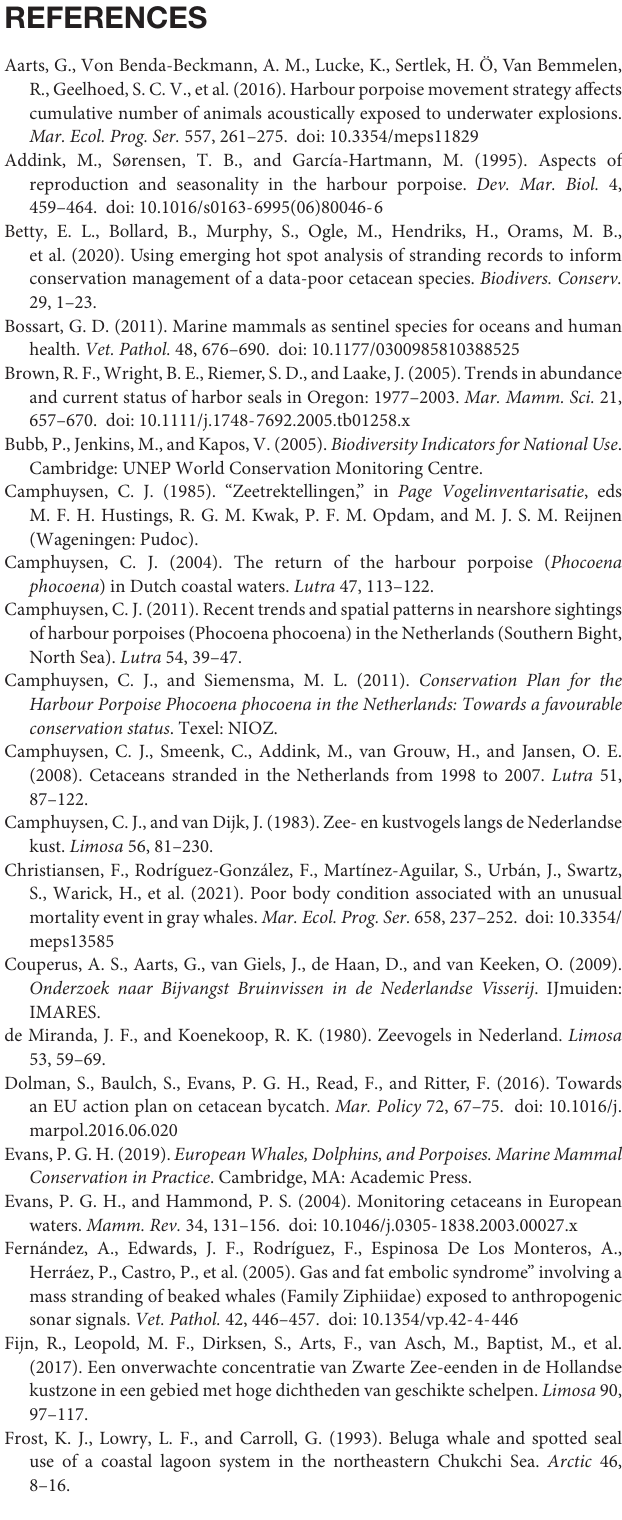
Supplementary Figure 5 | The observed and predicted stranding rate of the best model with and without an AR1 correlation structure.